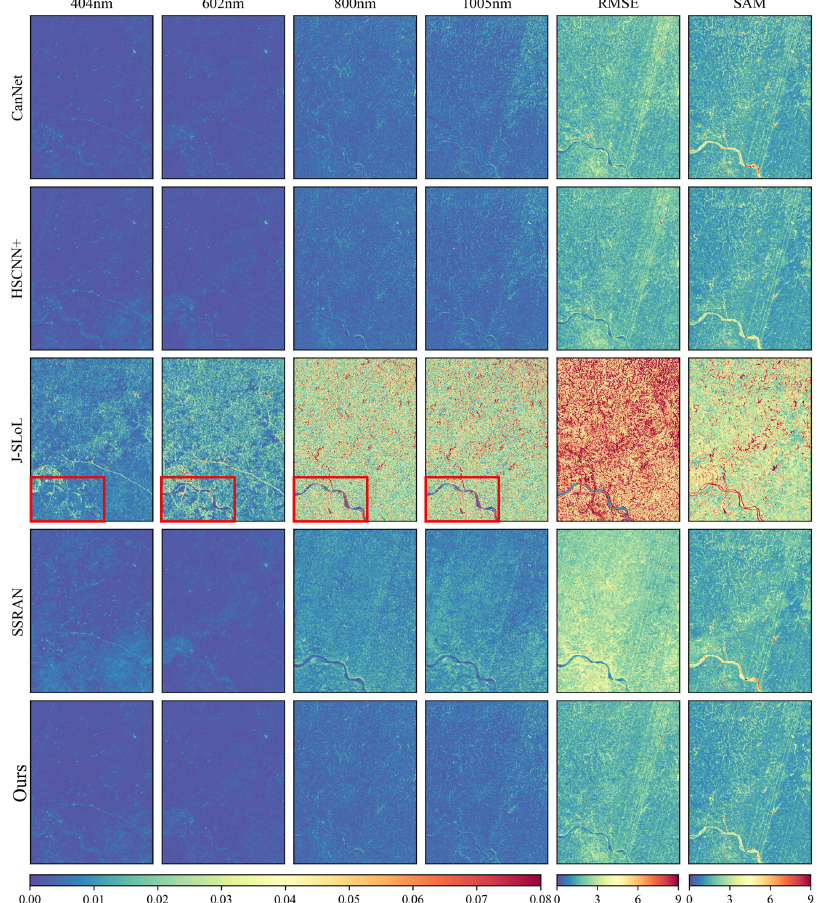
Figure 7. Visualization of SSR results of five methods with ZY1-02D dataset. Columns 1 to 4 show the absolute error of a single band. Columns 5 and 6 show the overall RMSE and SAM errors for all bands, the highlighted areas in the red rectangle are river and